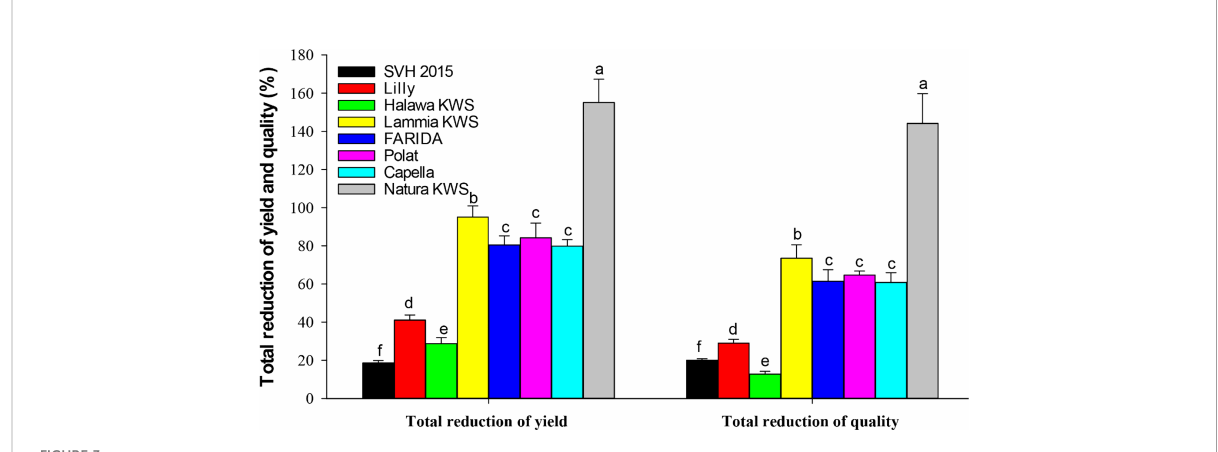
FIGURE 3 Total reduction % yield and quality characters of the screened sugar beet (Beta vulgaris saccharifera) varieties as in fl uenced by root-knot nematode, Meloidogyne incognita infection. Mean values followed by different letters are signi fi cantly (P<0.05) different from each other according to Duncan ’ s Multiple Range